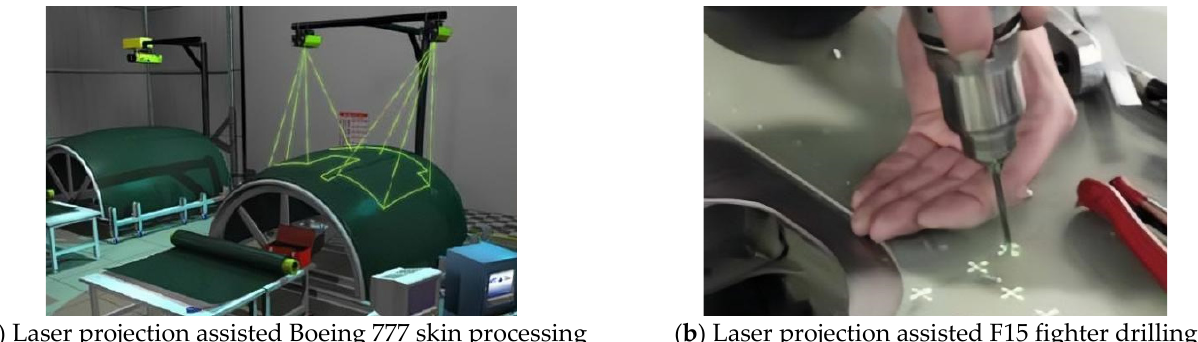
Figure 1. Laser projection technology originated in aerospace composite material manufacturing and processing.